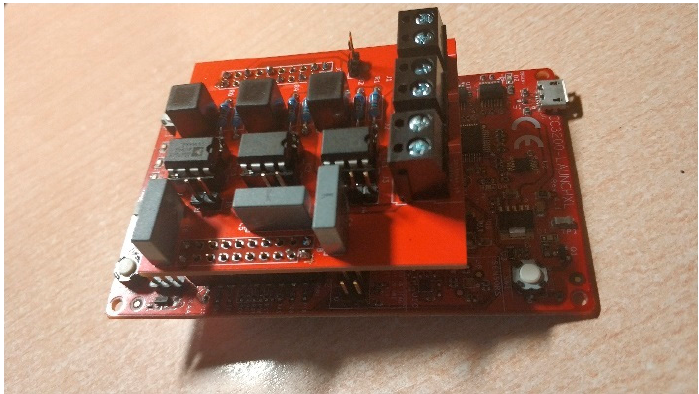
Figure 14. Conditioning circuit assembled into Lanchpad CC3200.